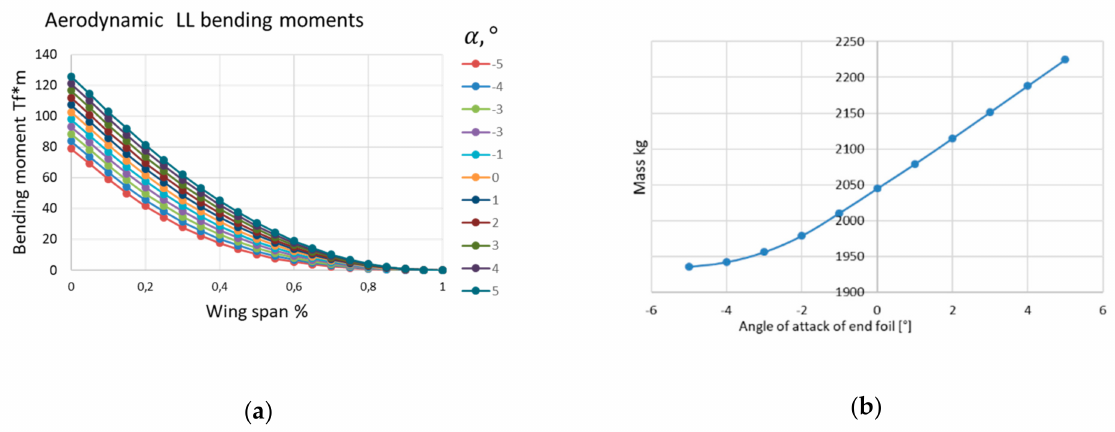
Figure 13. Bending moments ( a ) and masses of the regional aircraft ( b